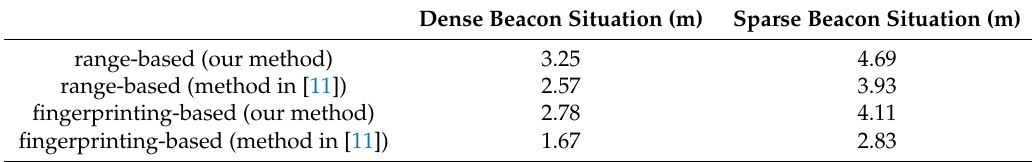
Table 6. Mean positioning error comparisons of our method and the method reported in